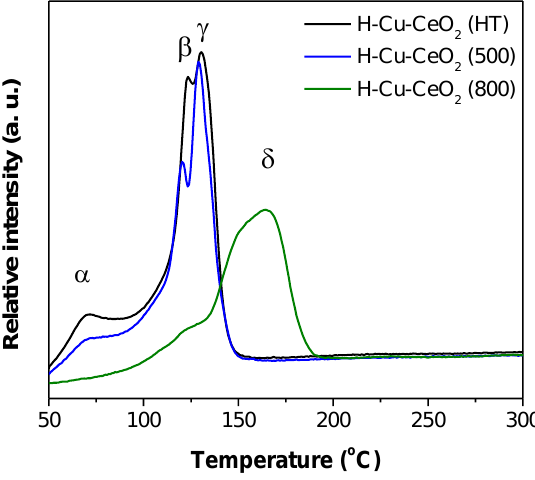
Figure 5. H 2 -TPR profiles of the H-Cu-CeO 2 catalysts.